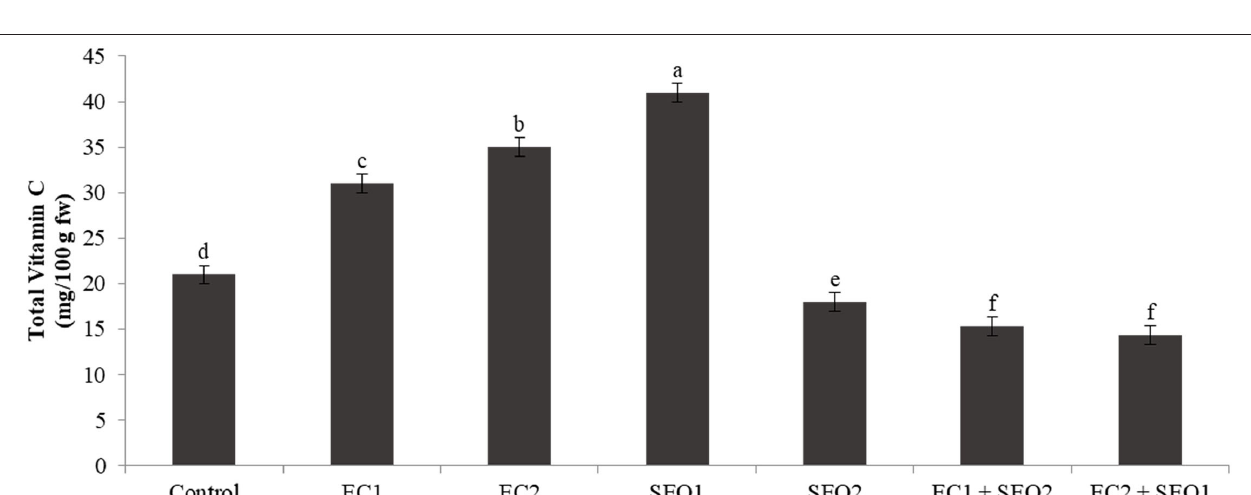
FIGURE 4 | Total phenolics (mg GAE/kg fw) and flavonoids (mg RE/kg fw) content of tomato fruits under control (C, 0.4 dS/m), saline (EC1, 3.5 dS/m; EC2, 7 dS/m), spent engine oil stress (SEO1, 0.5%; SEO2, 1%) and the combinations (EC1/SEO2, 3.5 dS/m EC/1% SEO), (EC2/SEO1, 7 dS/m EC/0.5% SEO). Values are means ( n = 3).